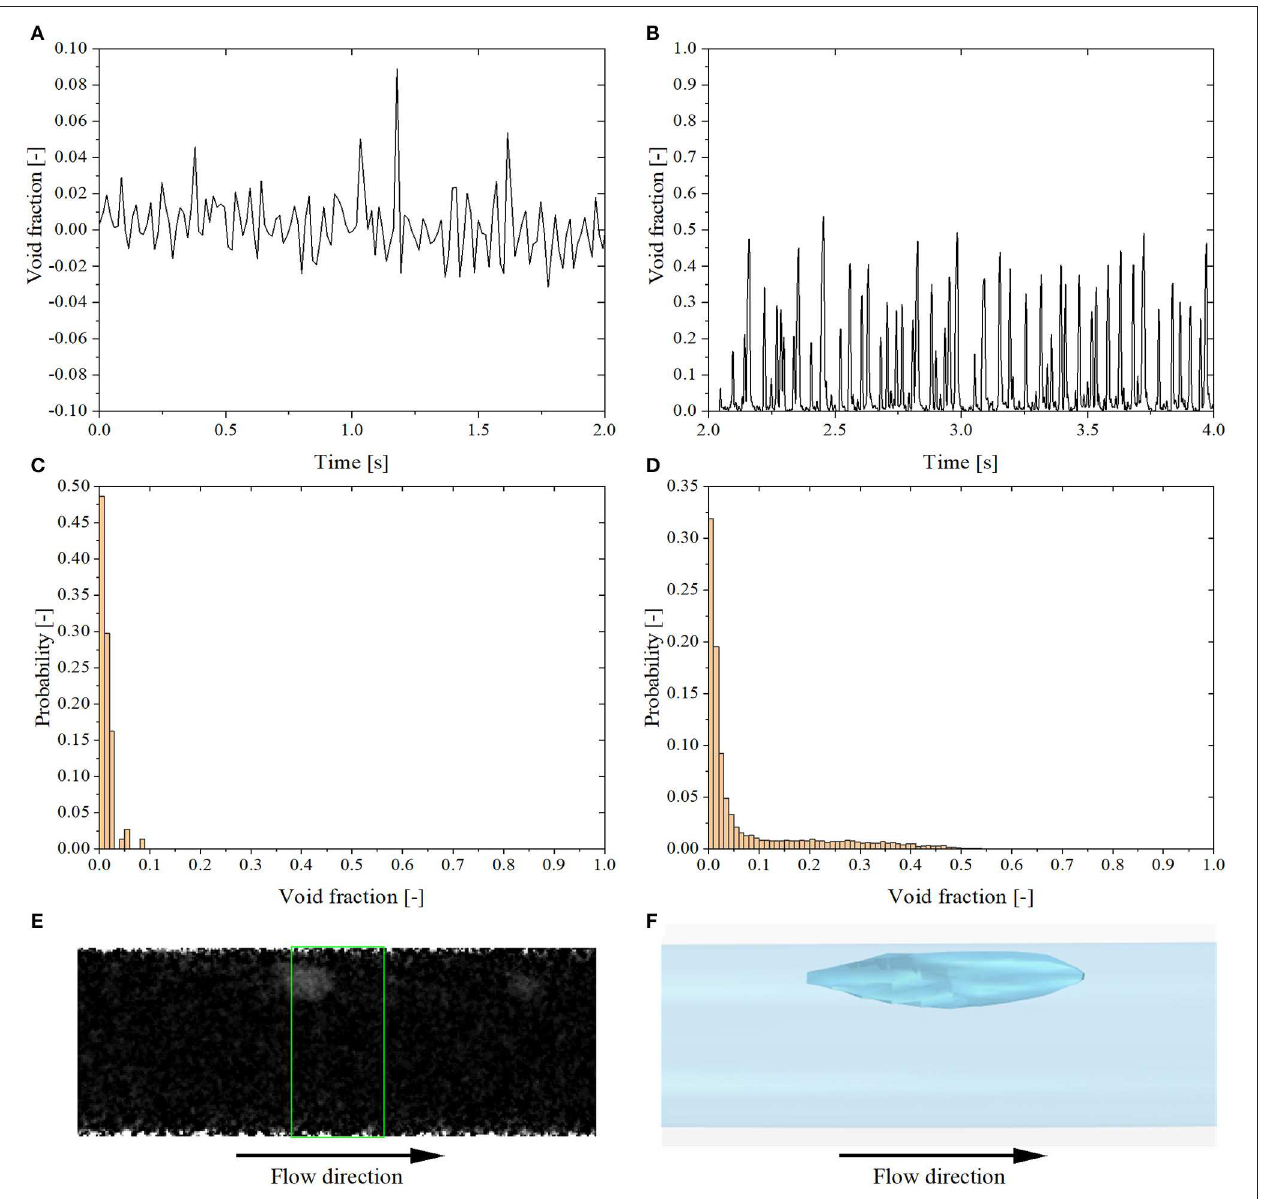
FIGURE 6 | Results of test No. 2. (A) Experimental void fraction time evolution. (B) Simulation void fraction time evolution. (C) Experimental void fraction histogram. (D) Simulation void fraction histogram. (E) X-ray void fraction contrast image. (F) Void fraction isosurface image.